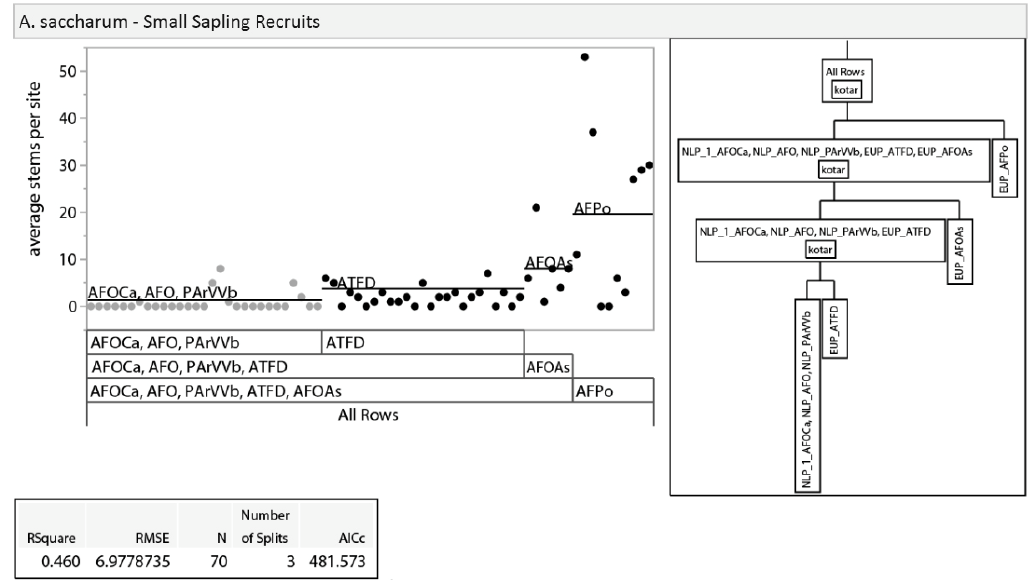
Figure A1. Results of recursive partitioning. Recursive partitioning was used to visually compare stem densities of the three smallest size classes of the three most dominant species (sugar maple, red maple, and American beech) to assess regional separation. Black dots represent data points from EUP, while grey dots represent data points from NLP. Table A1. Results of nonparametric Wilcoxon tests. Results of nonparametric Wilcoxon tests comparing stem densities of the three smallest size classes of the three most dominant species across similar habitat types between regions: High compares the two high classes between regions (NLP–AFOCa and EUP–AFOAs), Medium compares the two medium classes (NLP–AFO and EUP–AFPo), and Low compares the two low classes (NLP–PArVVb and EUP–ATFD). Bold values indicate significance after Bonferroni correction ( p ≤ 0.0019).